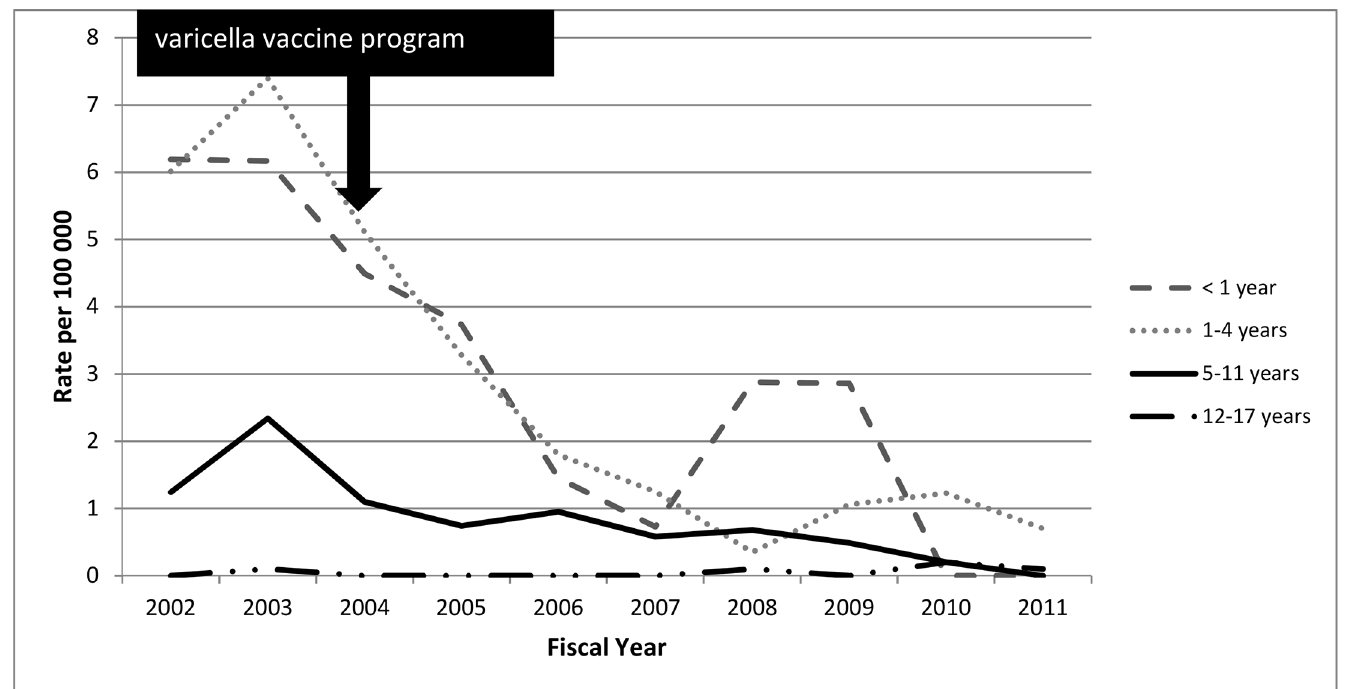
Fig 2. Age-specific varicella physician office visits among Ontario children by fiscal year, 1992 – 2011.